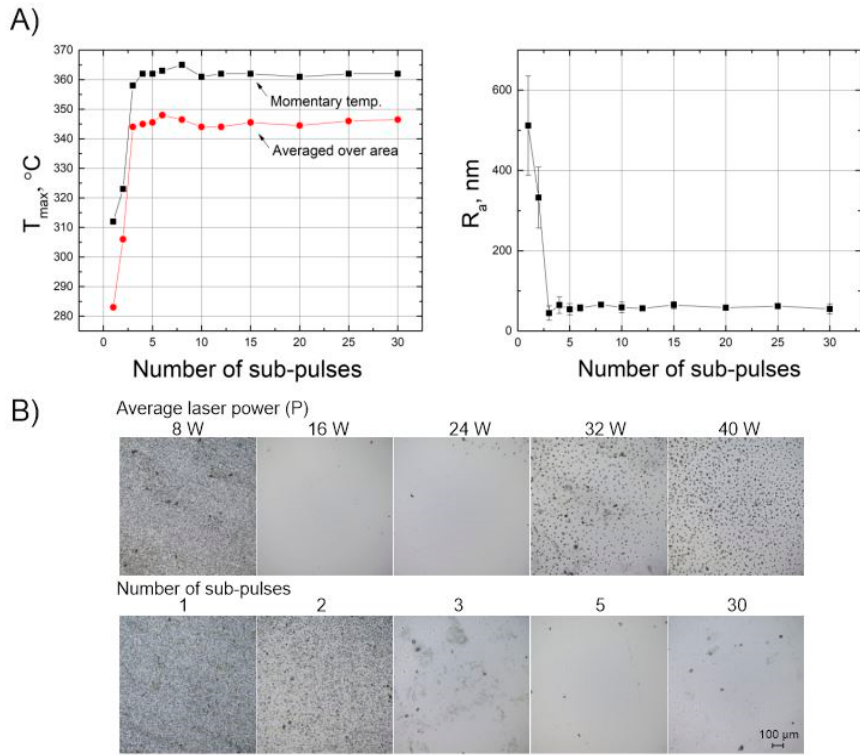
Figure 8. Surface temperature dependence on the number of sub-pulses within a burst (left picture), surface roughness dependence on the number of sub-pulses within a burst (right picture). Other parameters: P = 16 W, dx = 10 µ m, v = 700 mm / s and number of scans = 2 ( A ). The surface of the sample after polishing using di ff erent average laser power when other parameters are N p = 10, dx = 10 µ m, v = 700 mm / s and number of scans = 2 ( B , first line). The surface of the sample after polishing using di ff erent numbers of sub-pulses when other parameters are P = 16 W, dx = 10 µ m, v = 700 mm / s and number of scans = 2 ( B , second line).